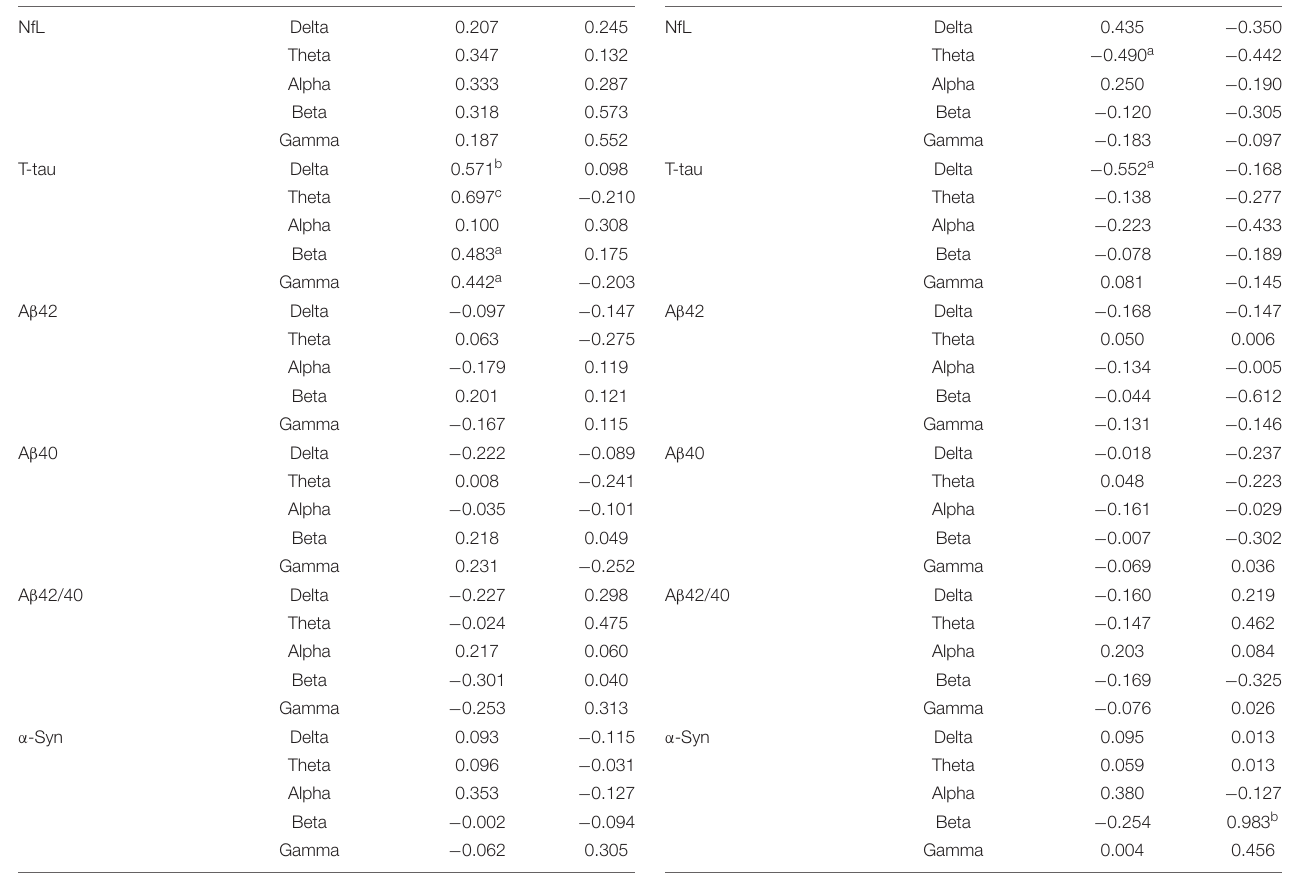
TABLE 3 | Correlation between plasma biomarkers and k PLI . Plasma biomarker